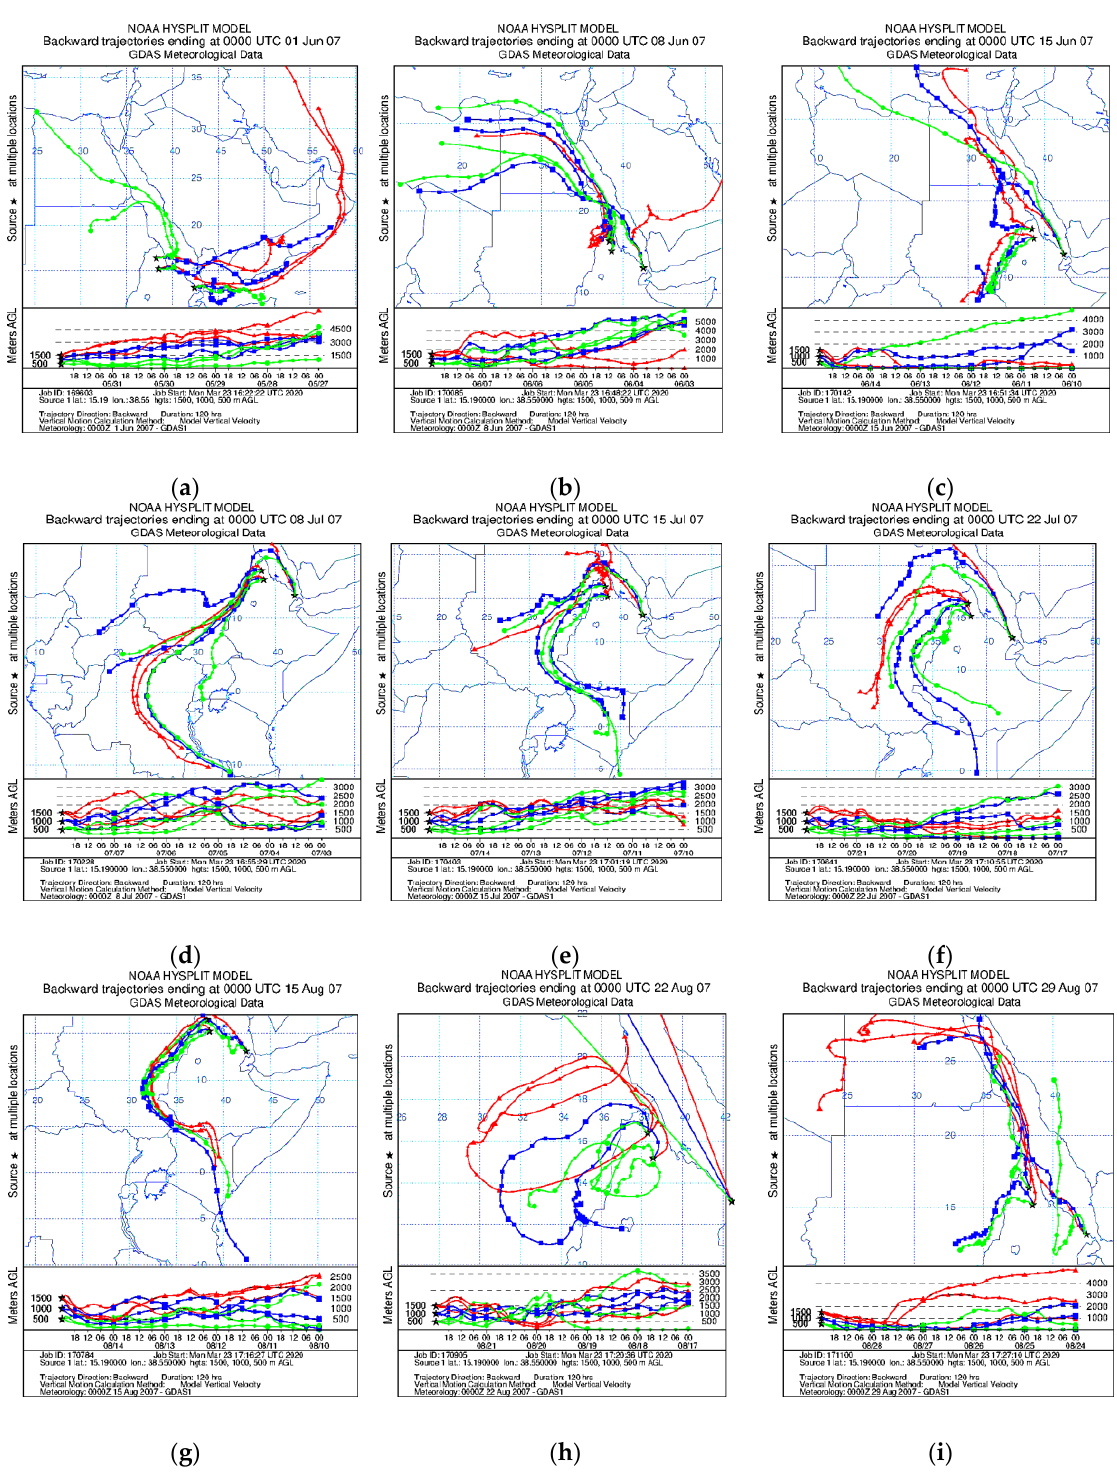
Figure 10. HYSPLIT back trajectory during the start ( a , b , c ), middle ( d , e , f ), and end ( g , h , i ) of JJA of the year 2007. regions were the Arabian deserts, the North African region (route of the Red Sea), and Sudan at all levels. The selected continental stations included Asmara, Assab, and